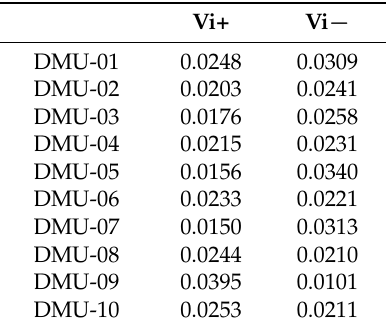
Figure 3. Final ranking score. Table 8. Negative ideal solution (NIS) and the positive ideal solution (PIS) value from the Technique for Order of Preference by Similarity to Ideal Solution (TOPSIS)